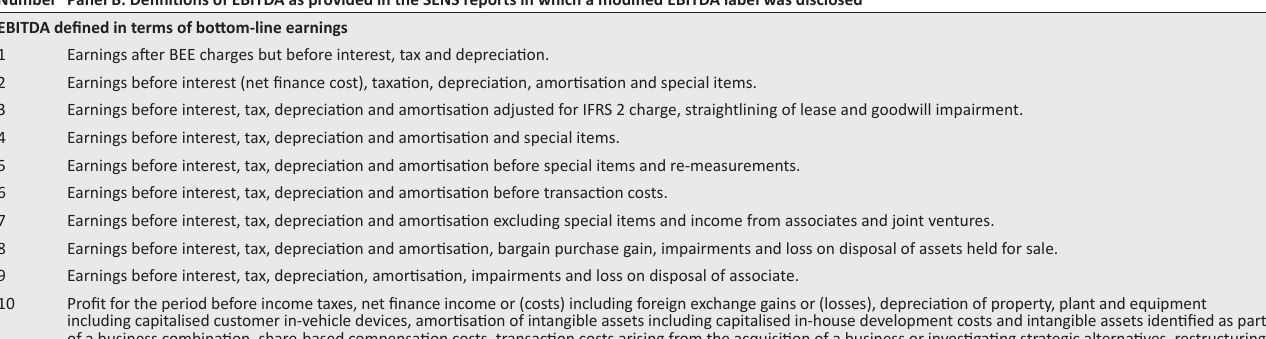
TABLE 4b: List of non-standard definitions of earnings before interest, tax, depreciation and amortisation in Stock Exchange News Service reports from 2014 to 2016 ( N = 220). Number Panel B: Definitions of EBITDA as provided in the SENS reports in which a modified EBITDA label was disclosed EBITDA defined in terms of bottom-line